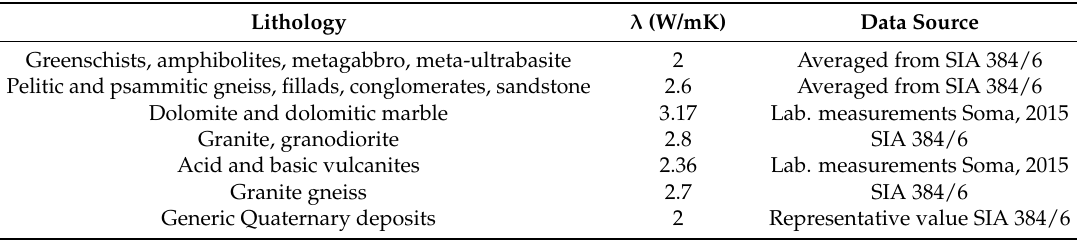
Table 5. Thermal characterization of outcrops and unmonitored Quaternary portion for in Cantone Ticino.